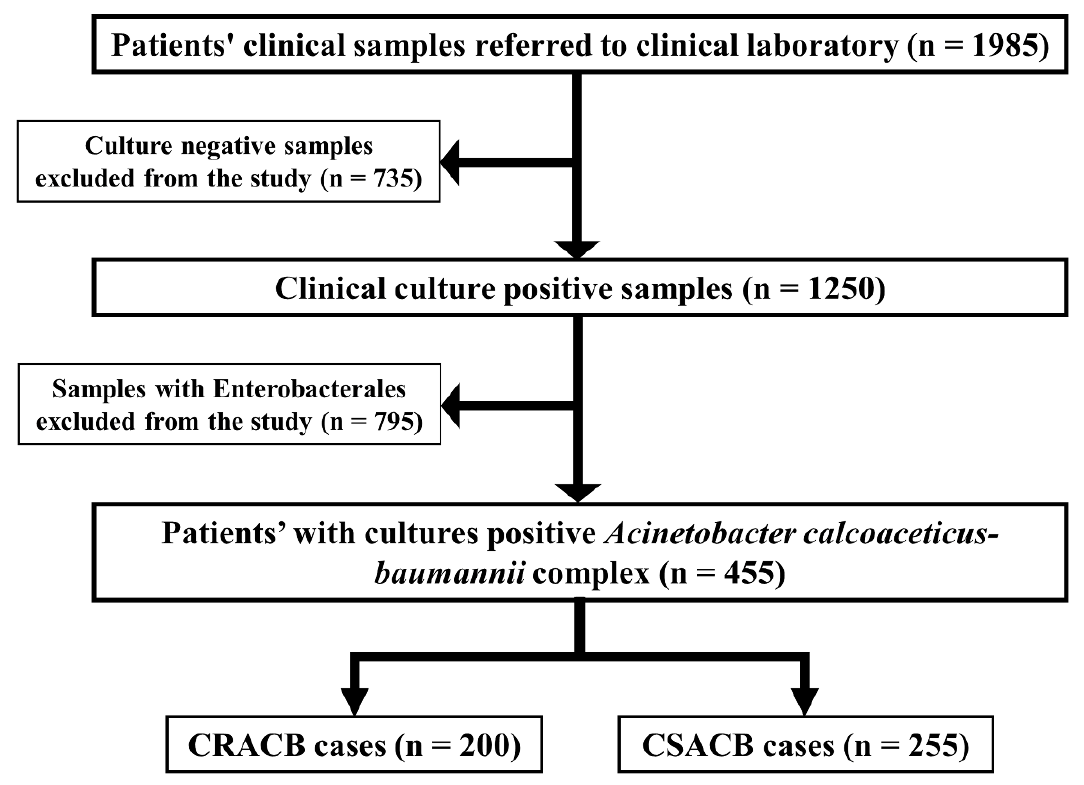
Figure 5. Collection of clinical samples and selection of cases with carbapenem-resistant Acinetobacter calcoaceticus - baumannii complex (CRACB) strains. Cases with carbapenem-sensitive A. calcoaceticus - baumannii complex (CSACB) were excluded from the study.